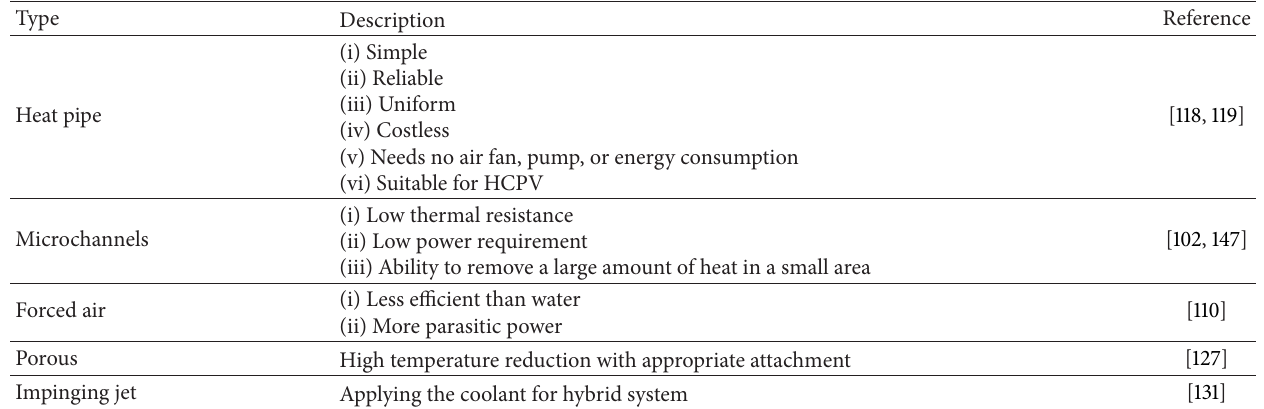
Table 8: Main characteristics of different cooling